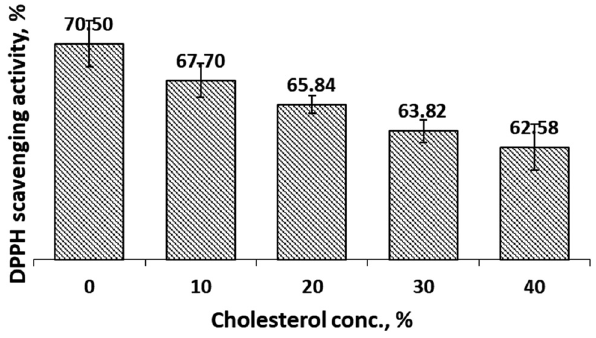
Figure 12: DPPH scavenging activity of CCL in SGF solution as a function of